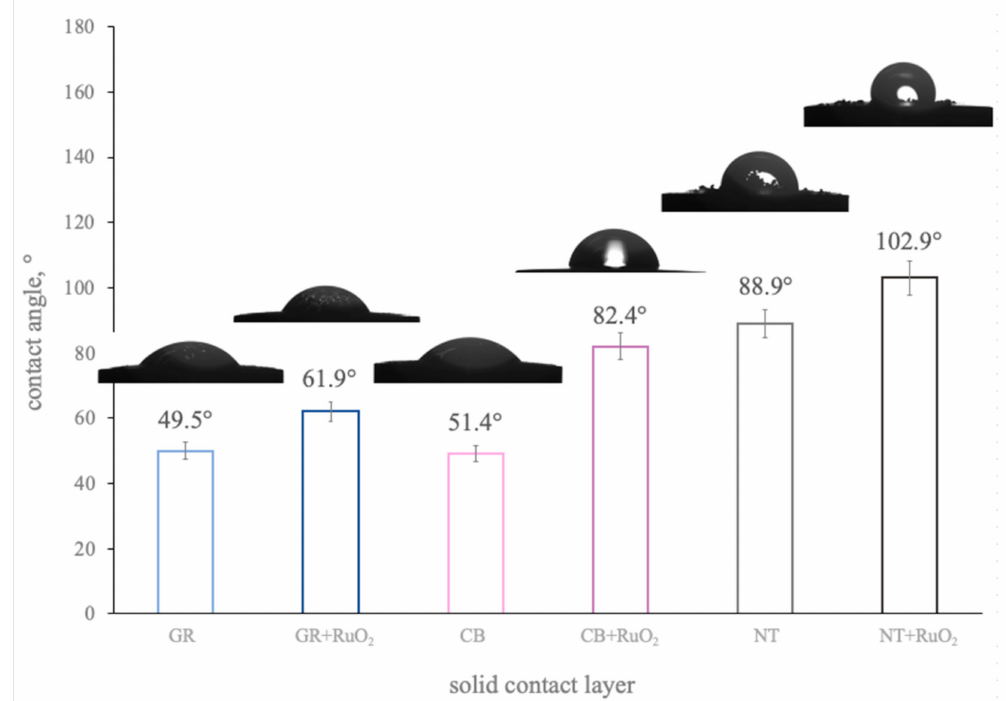
Figure 4. Contact angles of the studied layers; from left—graphene, GR + RuO 2 composite, carbon black, CB + RuO 2 composite, nanotubes, and NT + RuO 2